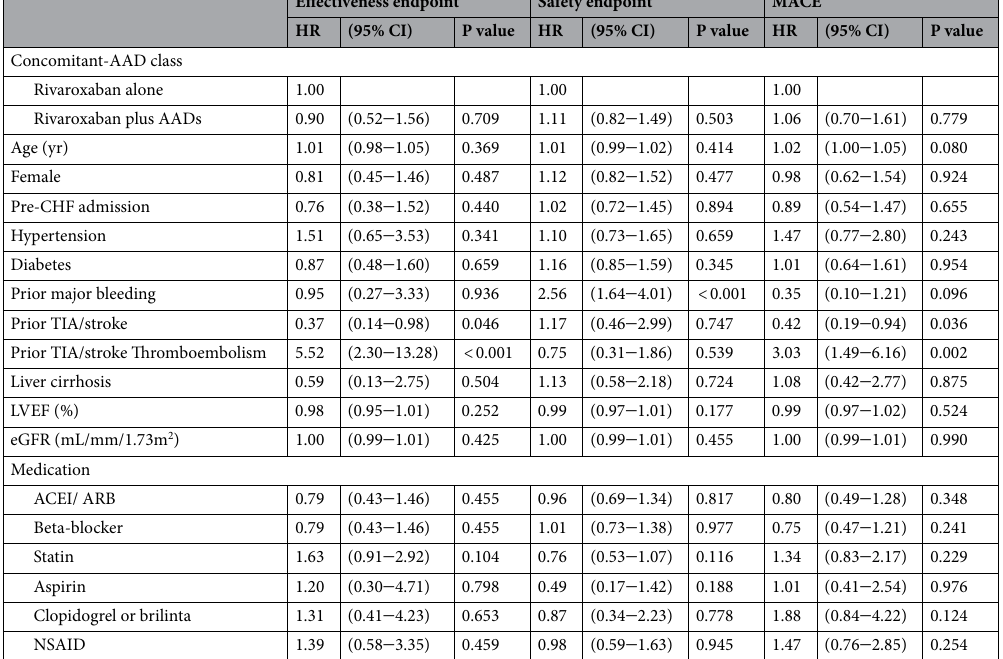
Table 3. Multivariate Cox regression analysis for effectiveness, safety, and MACE outcomes of atrial fibrillation patients with receiving either rivaroxaban alone or concomitant AADs. AADs, anti-arrhythmia drugs.